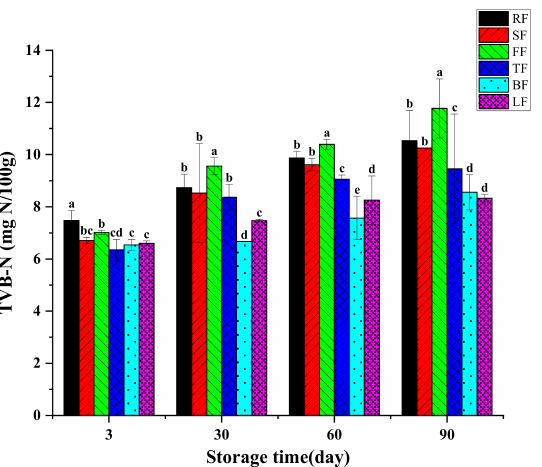
Figure 6. Change in TVB-N content of cuttlefish during storage at − 18 ◦ C by different freezing meth- ods. The letters “a–e” indicate significant differences ( p < 0.05). Error bars show standard